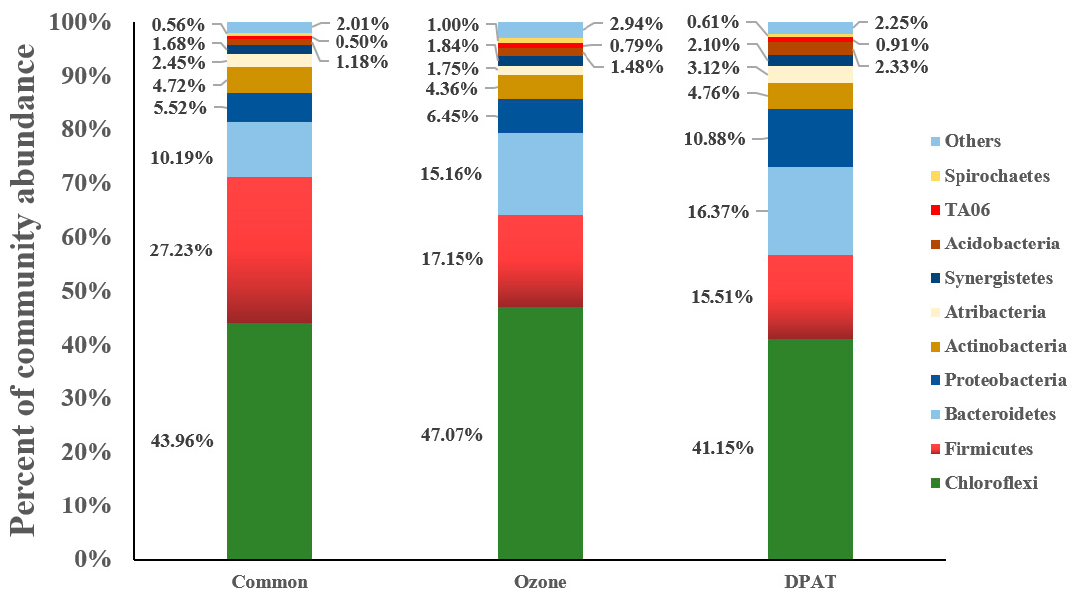
Figure 7. The community proportions in the sludge from common anaerobic treatment, ozone pre- pretreatment, and DPAT treatment, and DPAT treatment.